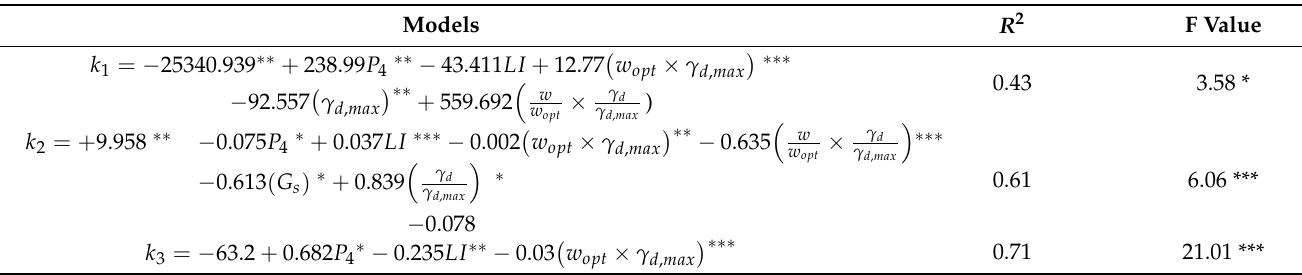
Table 5. Developed Constitutive Models of Coefficients.